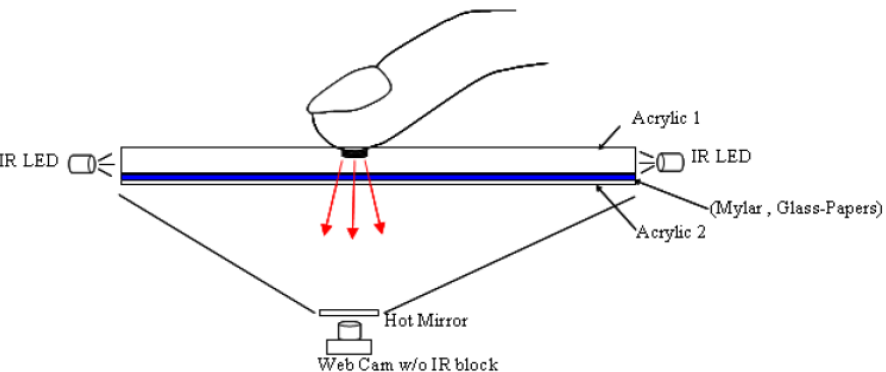
Figure 3. The structure of the proposed multi-touch sensing